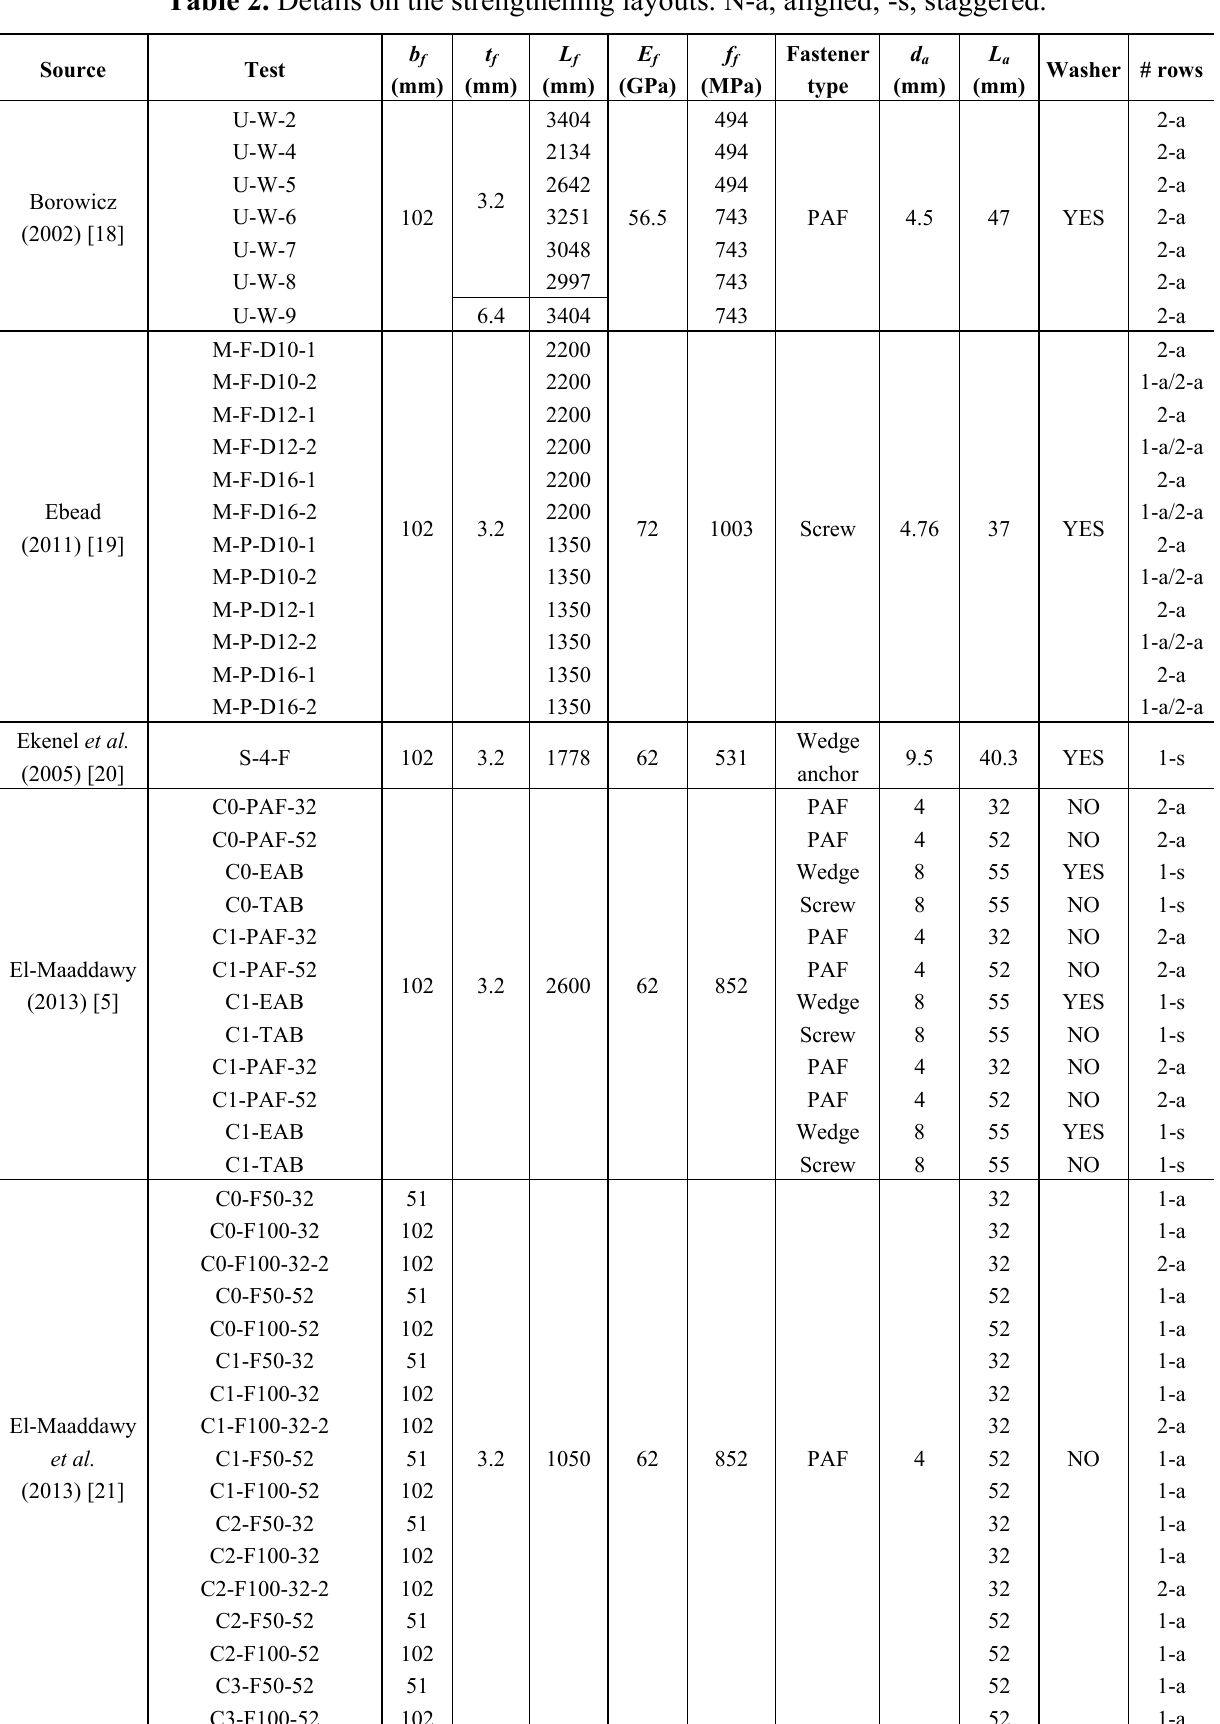
Table 2. Details on the strengthening layouts. N-a, aligned; -s, staggered. Source